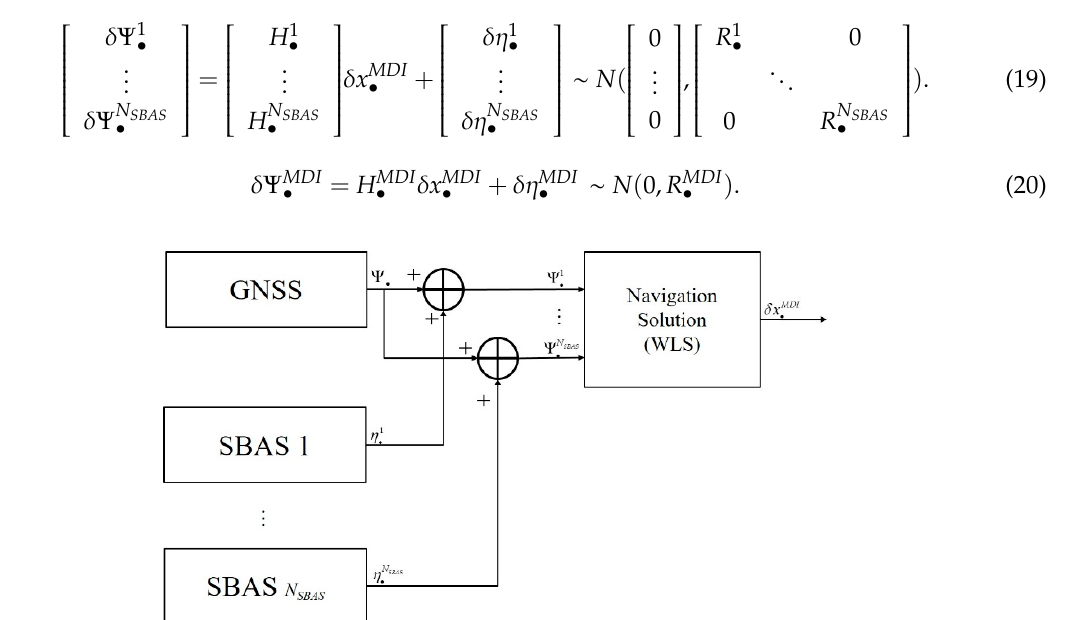
Figure 3. Measurement domain integration (MDI) for single GNSS augmented with multi-SBAS.